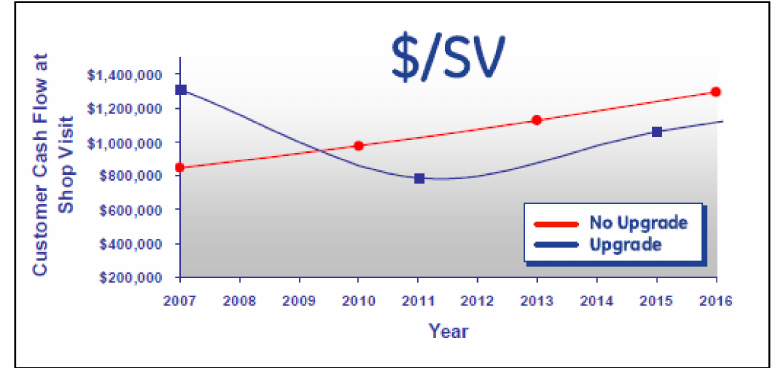
Figure 4. Customer cash flow at shop visit per